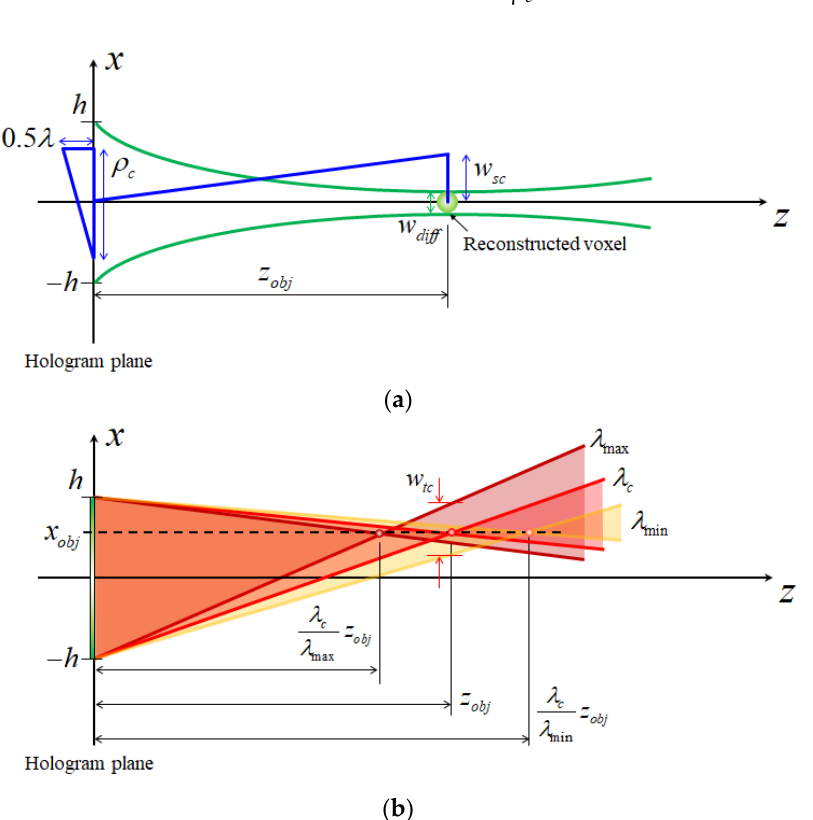
Figure 4. The effect of coherence on the size of the voxel reconstructed in the digital holographic display. ( a ) The width of the voxel according to both the diffraction limit and the spatial coherence and ( b ) the width of the voxel according to the temporal coherence.